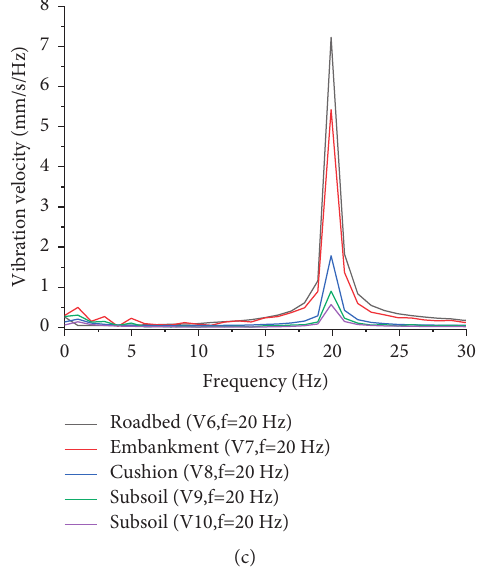
Figure 10: Frequency spectrum curves of vibration velocity at embankment, cushion, subsoil for three cyclic loading frequencies.